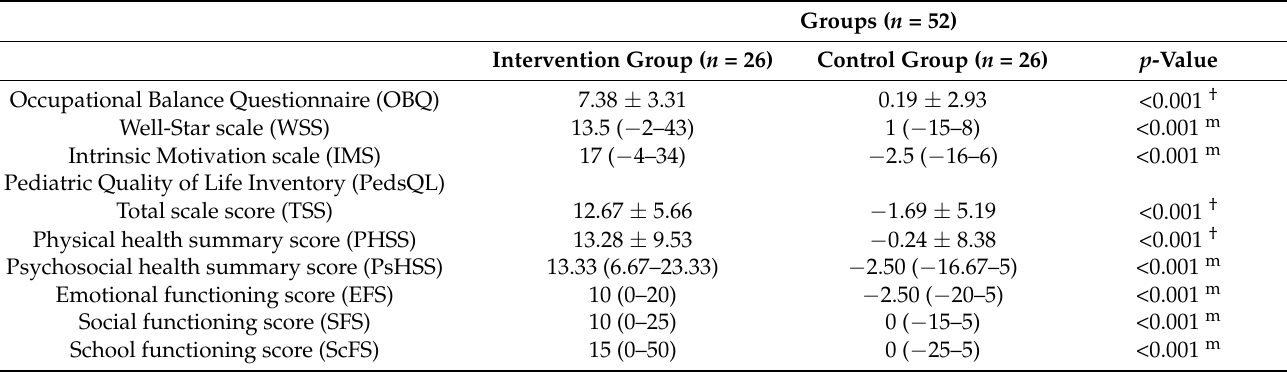
Table 7. Comparison of “score differences” between the intervention and control groups. Score differences were obtained as subtracting the baseline score from the post-intervention score for individual